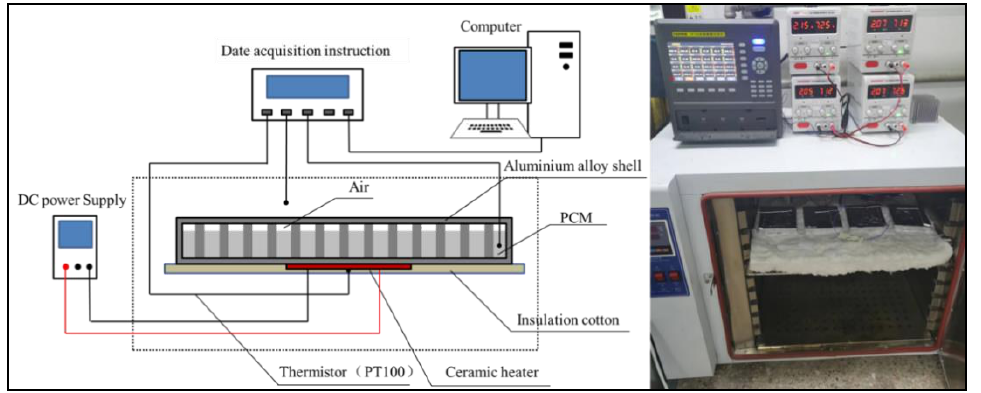
Figure 4. Experiment platform.